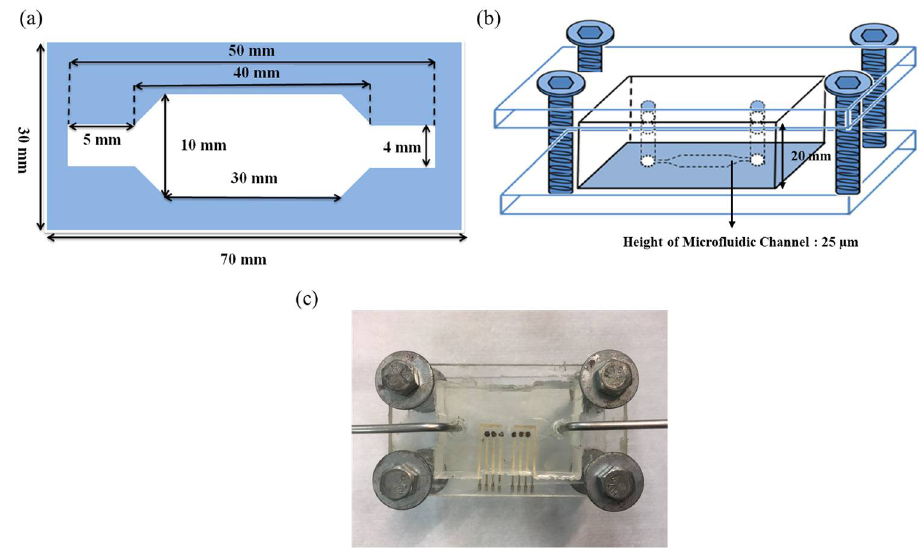
Figure 4. ( a ) The 2D and ( b ) 3D schematics of the microfluidic device. ( c ) The close-up image of the microfluidic device.